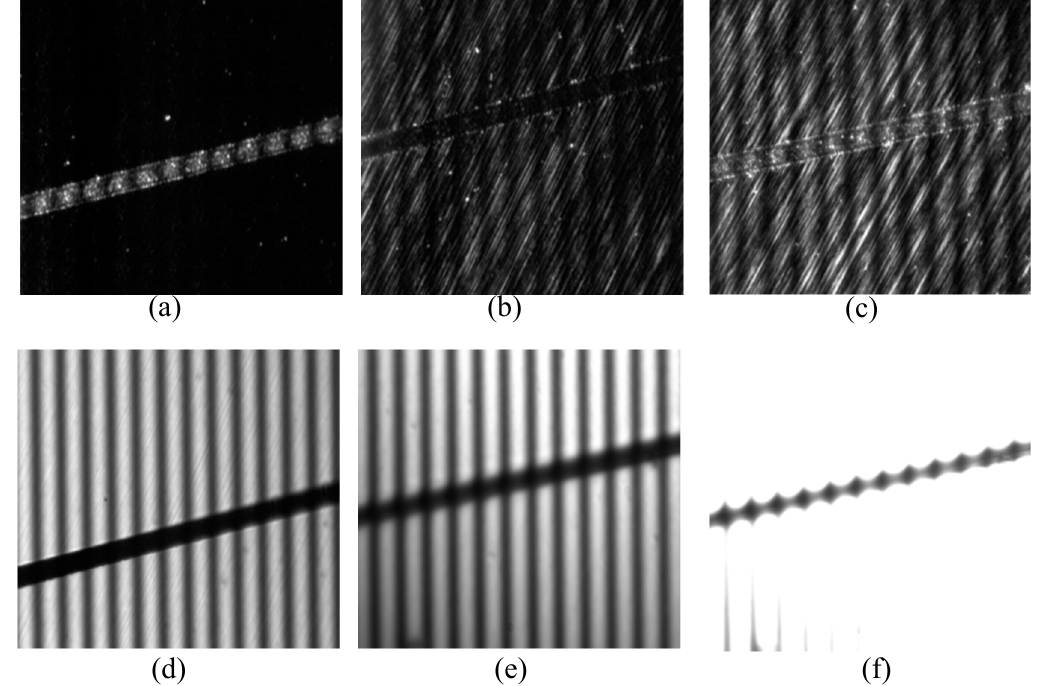
Figure 1. Images of wafer surface etched with a laser-etched groove and captured at different viewing angles: ( a ) viewing angle ± 1°, exposure time 420 ms; ( b ) viewing angle 12 ± 1°, exposure time 200 ms; ( c ) viewing angle 25 ± 1°, exposure time 80 ms;( d ) viewing angle 45 ± 1°, exposure time 20 ms; and ( e ) viewing angle 45 ± 1°, exposure time 50 ms.